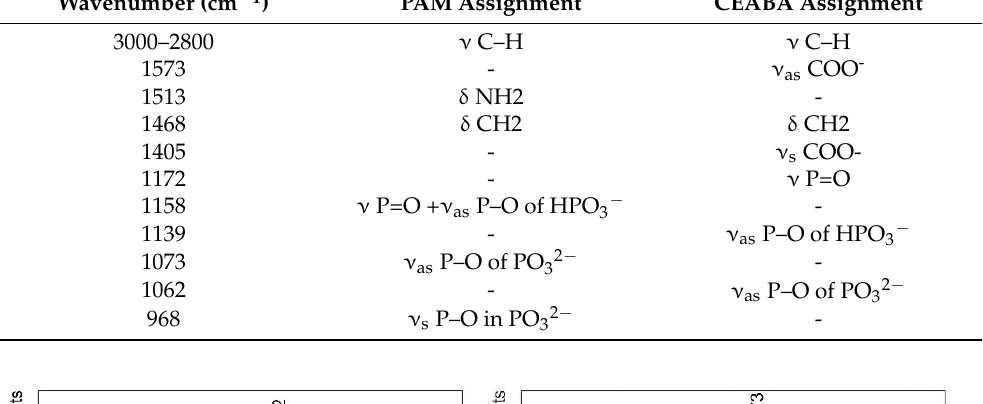
Table 1. The assignments of ATR-FTIR peaks for PAM and CEABA in aqueous solution at pH = 7.